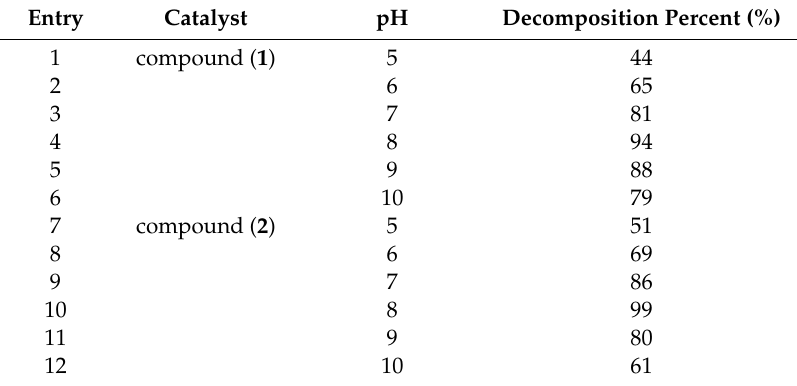
Table 3. The e ff ect of pH on the decomposition reaction of H 2 O 2